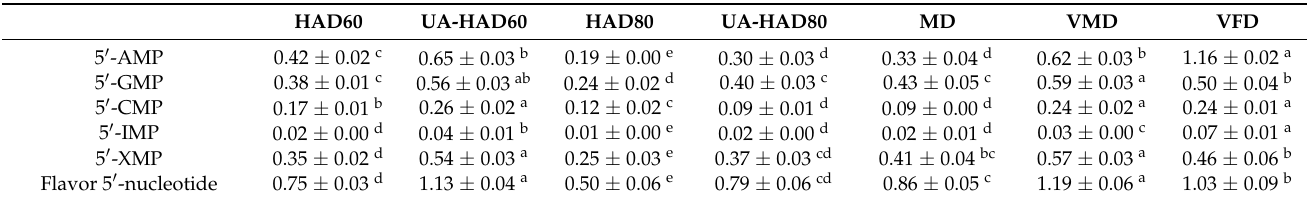
Table 4. The content of 5 (cid:48) -nucleotide of O. raphanipes subjected to different drying methods (mg/g dry